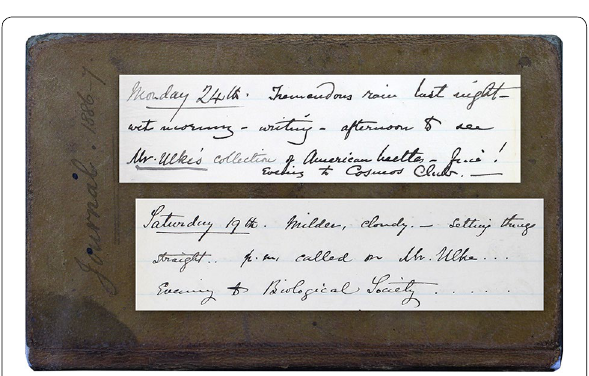
Fig. 5 North American Journal of Alfred R. Wallace (1886–1887), including two entries dealing with Henry Ulke on January 24 and March 19, 1887, respectively; courtesy of the Linnean Society of London (MS